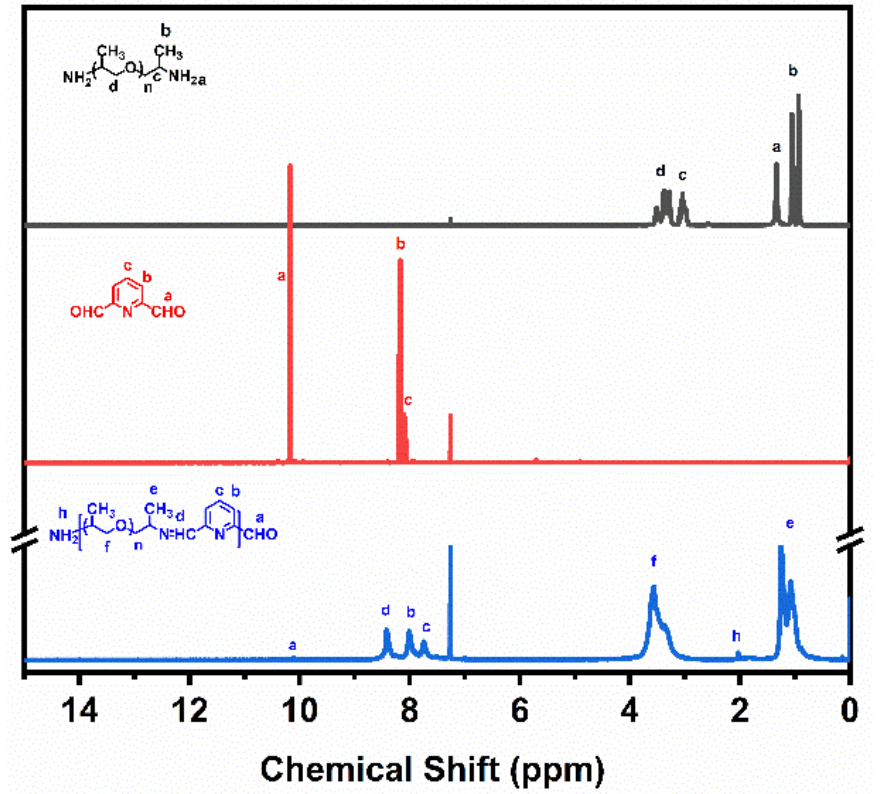
Figure 1. 1 H NMR spectra of monomers and Schiff base polymers in CDCl 3.